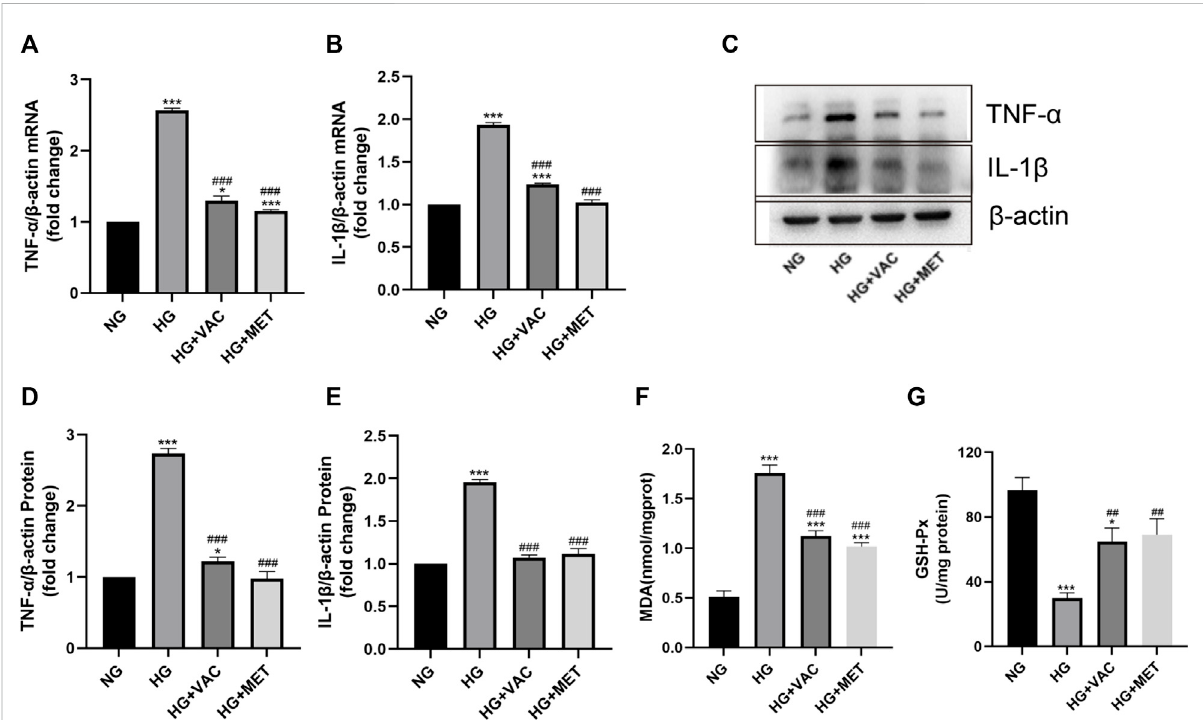
Vaccarinattenuated HG-inducedin fl ammatoryinjuryinHUVECcells. (A,B) .TheeffectsofvaccarinormetforminontheTNF- α mRNAandIL-1 β mRNA expression in HG-induced HUVEC cells. (C – E) . Western blotting analysis of TNF- α and IL-1 β protein expression levels in HG-induced